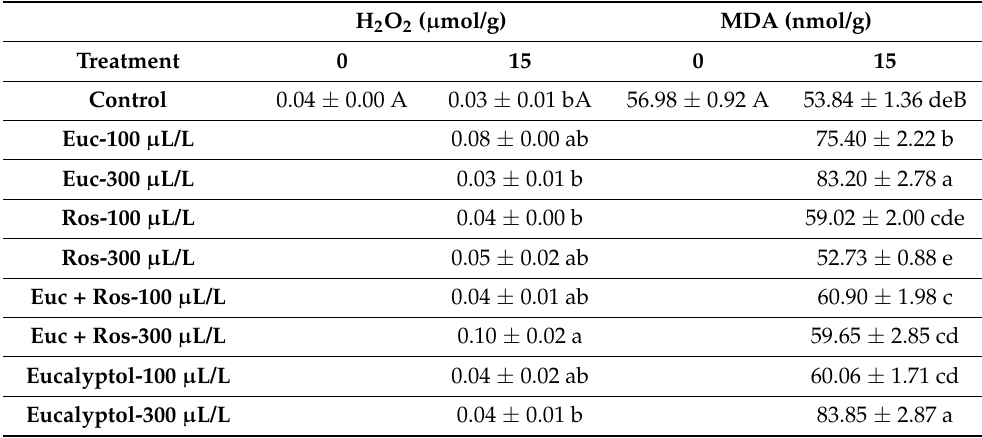
Significant differences ( p < 0.05) among treatments are represented with small different Latin letters. Table 4. Effects of eucalyptus EO (Euc), rosemary EO (Ros), their 50:50 mixture (Euc + Ros) and eucalyptol on damage index (H 2 O 2 and MDA) of inoculated with P. expansum apple fruits stored at 7 ◦ C for 8 days and subsequently at RT up to 15